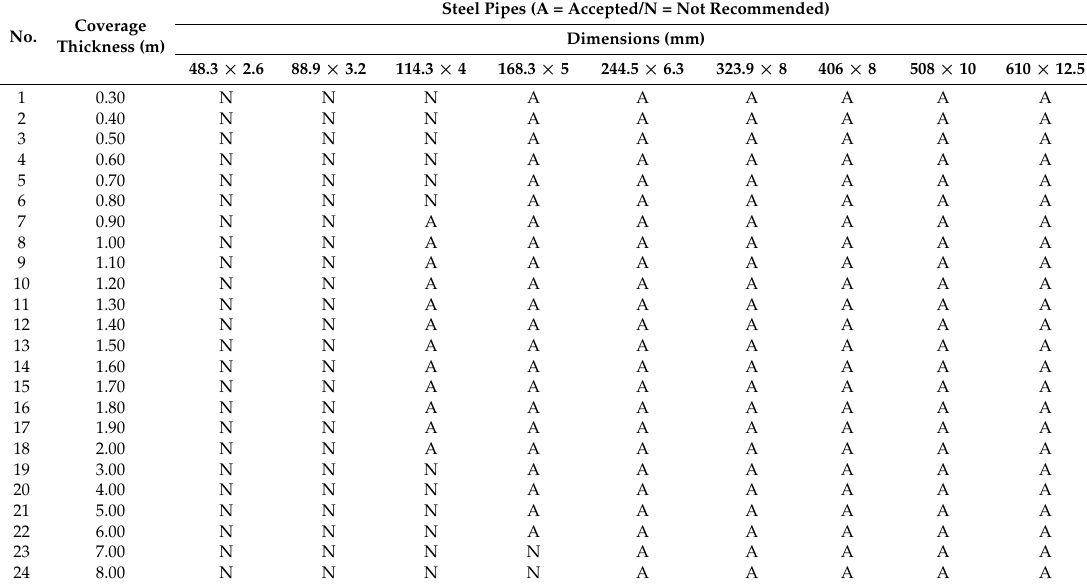
Table 9. Results of the calculations for steel pipes.